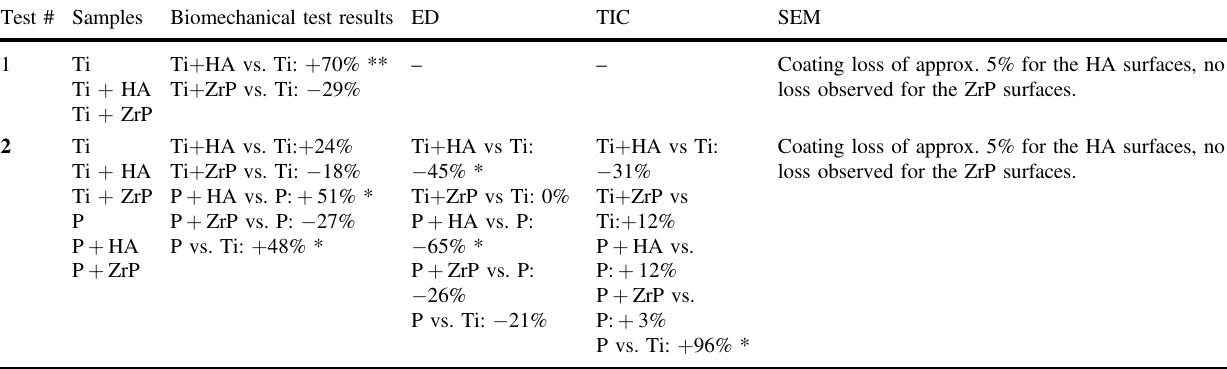
Table 3 Summary of test results Test #